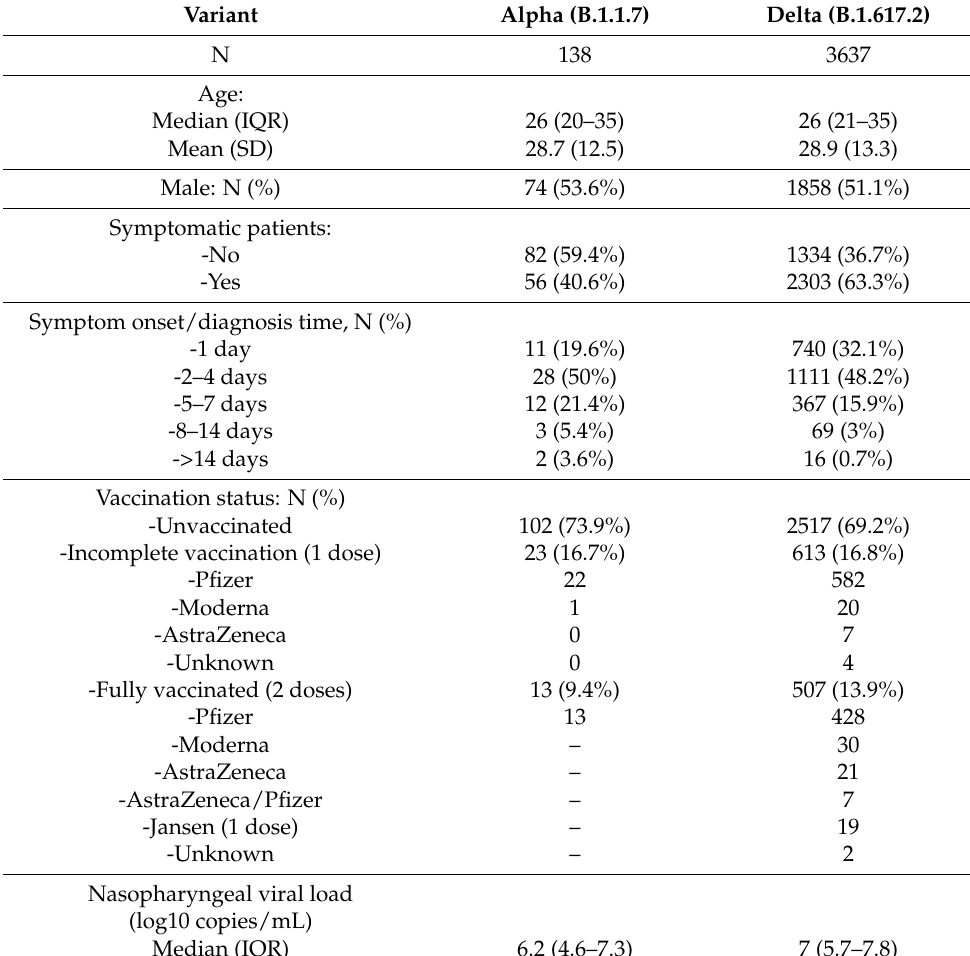
Table 1. Characteristics of Alpha and Delta variant COVID-19